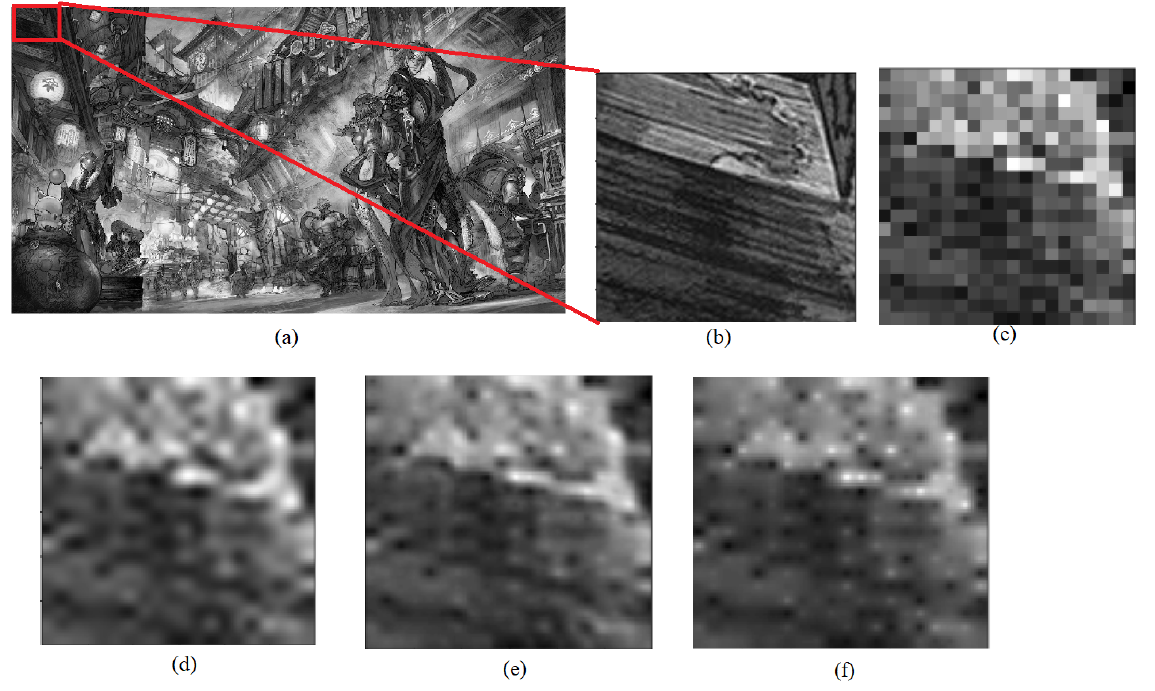
Figure 5. Comparison between wide network and deep network: ( a ) Original 1080p image; ( b ) 120 × 120 high-resolution segment; ( c ) 20 × 20 downsampled segment as a system input; ( d ) bicubic upsampled image [SSIM: 0.00816, MSE: 1514.09]; ( e ) wide network output [SSIM: 0.523, MSE: 57.67]; ( f ) deep network output [SSIM: 0.516, MSE: